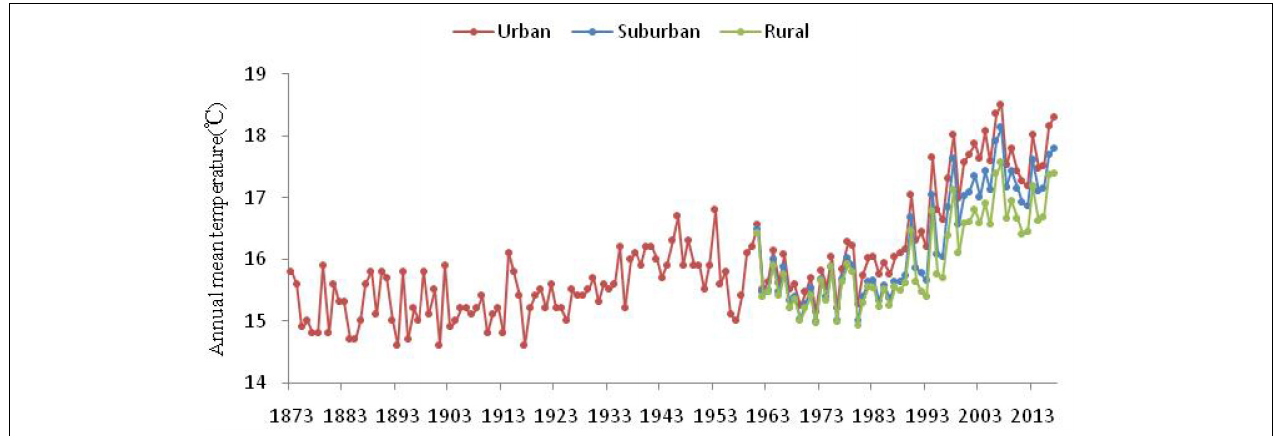
FIGURE 2 | Annual mean temperature of the urban, suburban, and rural areas since records began.